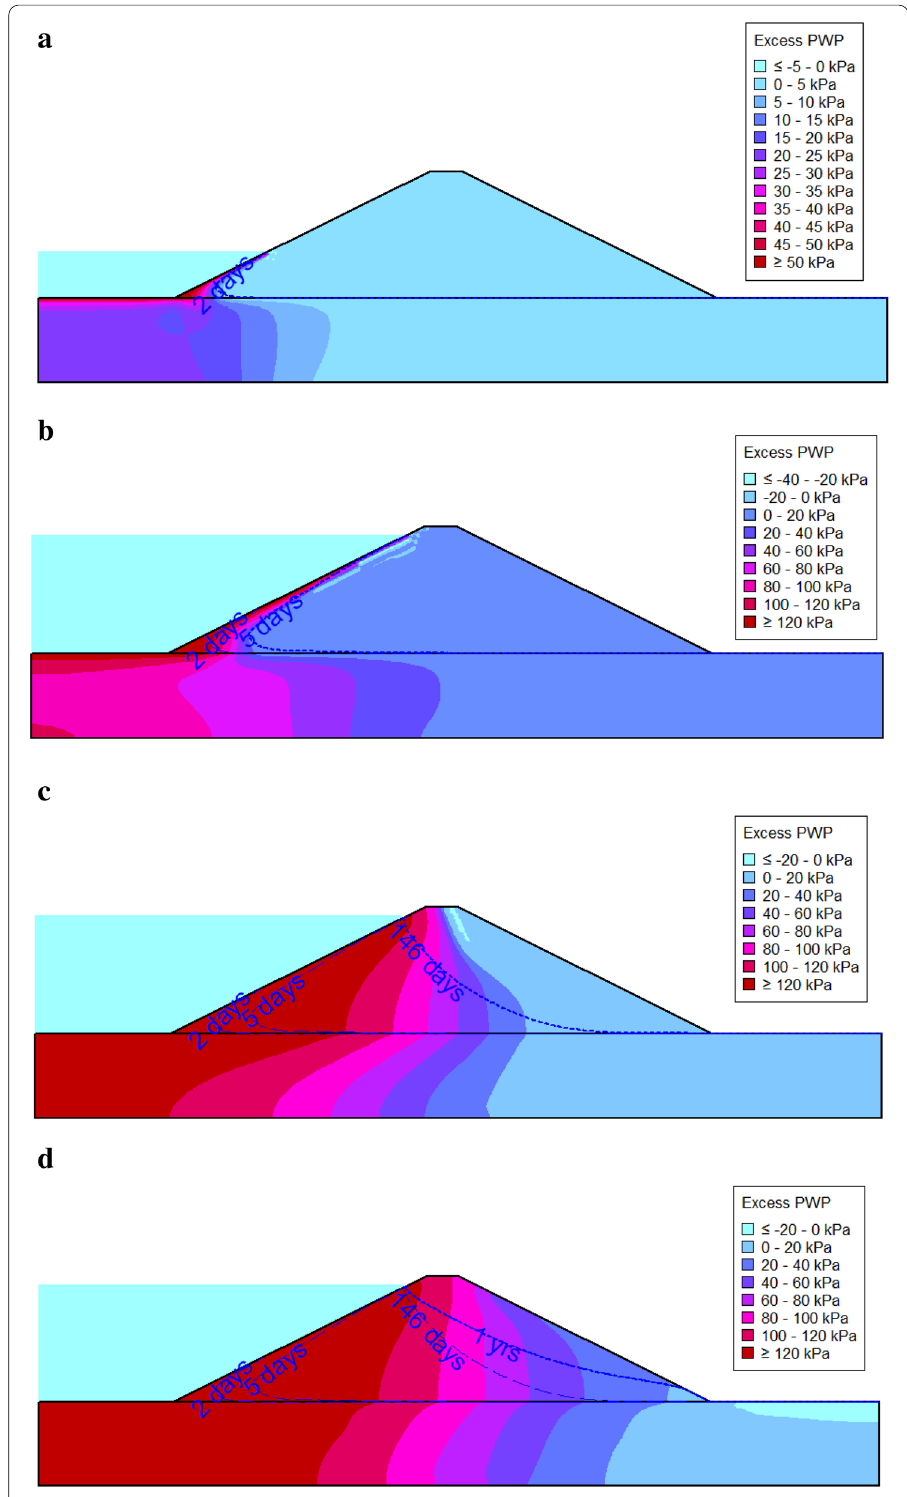
Fig. 13 PWP contours and the migration of phreatic surface during and after the reservoir filling operations a 2nd day, b 5th day, c 146th day, d 1